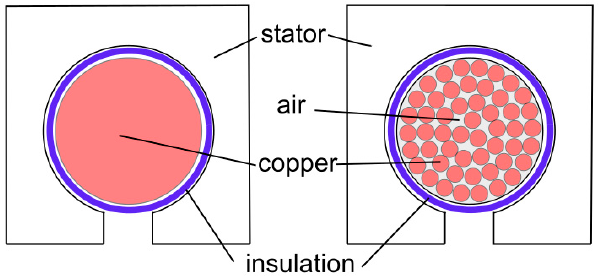
Figure 11. Illustration of slot filling for a solid conductor versus round conductors.